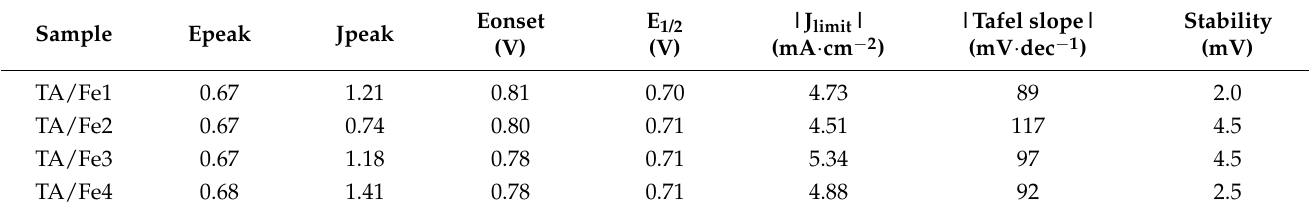
Table 3. ORR catalytic performance data of the as-prepared aerogels.